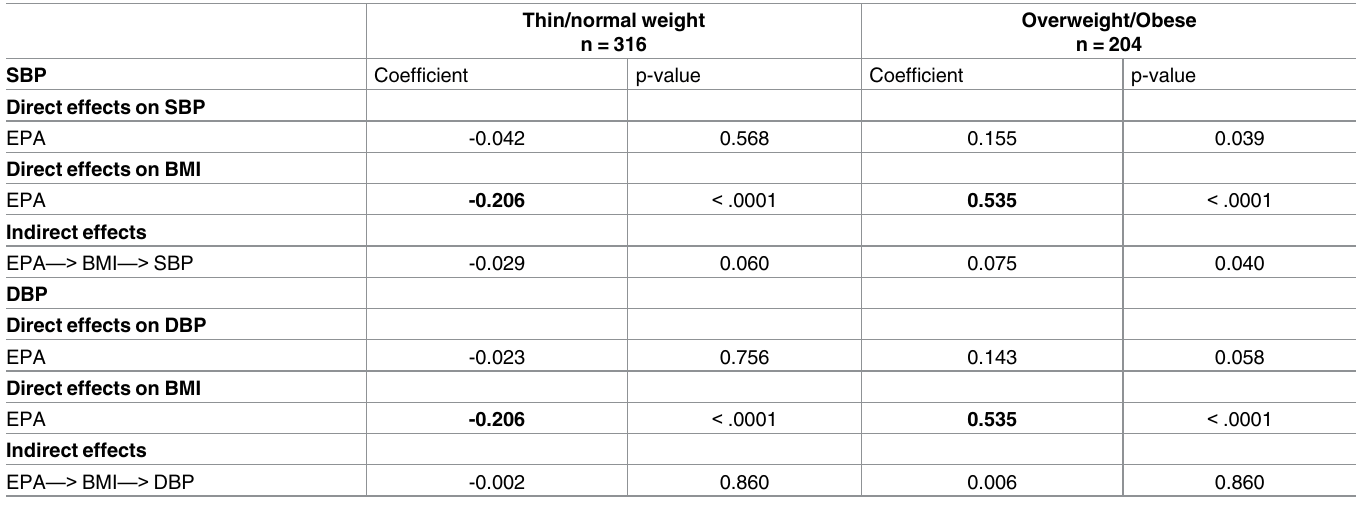
Table 5. Standardized estimatesof direct effects of EPA on BMI z-score and SBP z-score/DBP z-score and indirect effectsof EPA on SBP z-score/ DBP z-score via BMI z-score in thin/normal weight versus overweight/obese children obtained from path